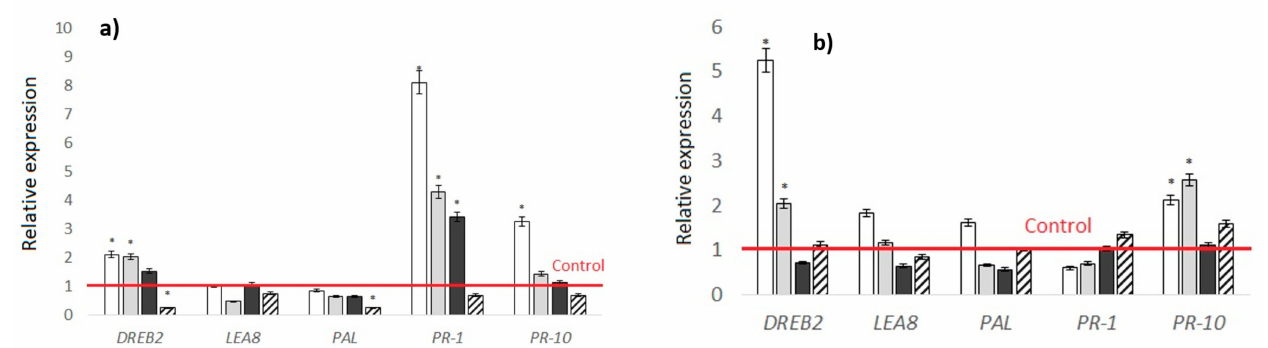
Figure 9. Expression of stress resistance genes in downy birch ( a ) and silver birch ( b ) plants: white columns—nanotubes at a concentration of 1 mg/L, gray columns—10 mg/L, black columns—50 mg/L and shaded columns—100 mg/L. Asterisks in the vertical bars represent signifi- cant differences between groups according to Duncan’s multiple range test at p <